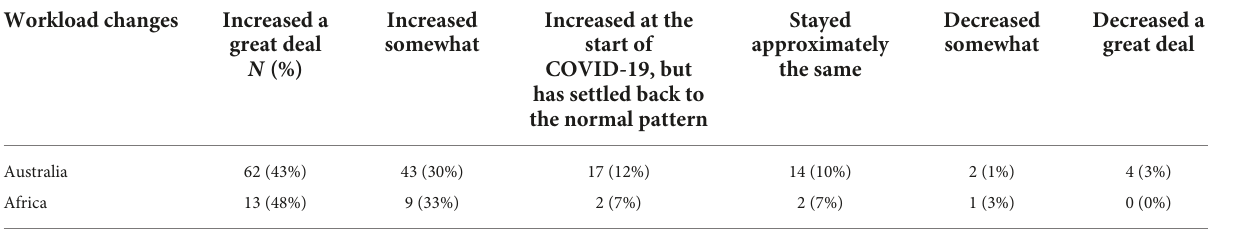
TABLE 1 Workload changes since the start of the